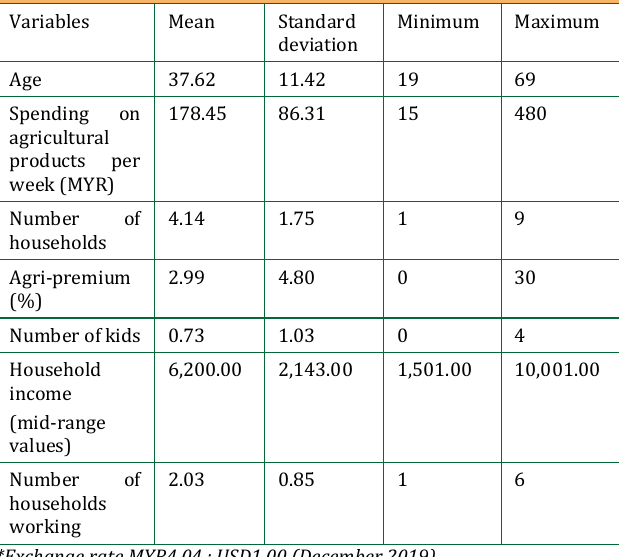
Table 1: Statistical analysis of respondents’ socio-economic profile